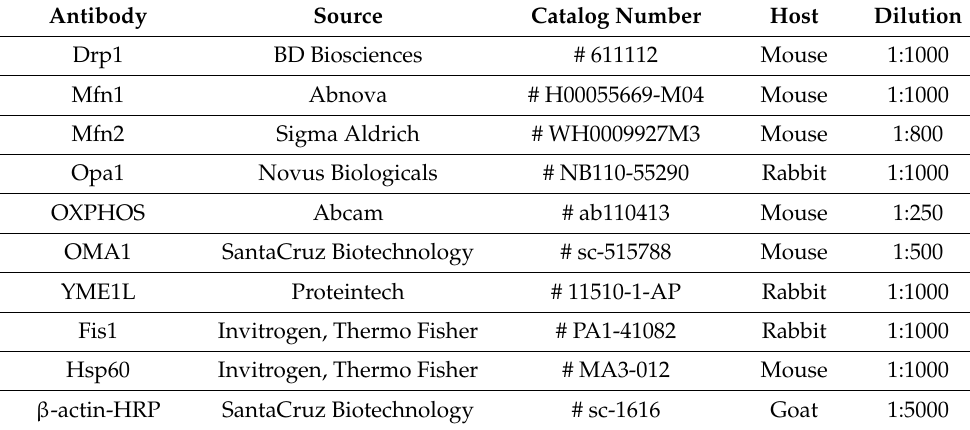
Table 2. Primary antibodies used in this